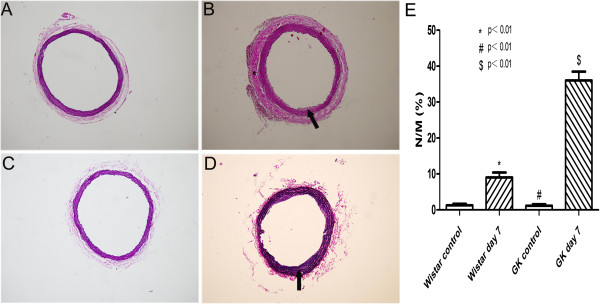
Morphological changes of rat common carotid arteries by E.V.G staining method (magnification ×200). (A) Wistar rats control. (B) Neointimal formation was seen in Wistar rats at day 7 after balloon injury. (C) GK rats control. (D) Visible neointimal formation was observed in GK rats at day 7 after balloon injury. (E) The degree of neointimal hyperplasia expressed by N/M in Wistar and GK rats after balloon injury increased significantly as compared to Wistar and GK rats control, respectively. N/M in GK rats was significantly higher than in Wistar rats. Arrows in images sign neointimal formation after balloon injury. * indicates Wistar control versus Wistar day 7, # indicates GK control versus GK day 7, $ indicates Wistar day 7 versus GK day 7. p<0.01.